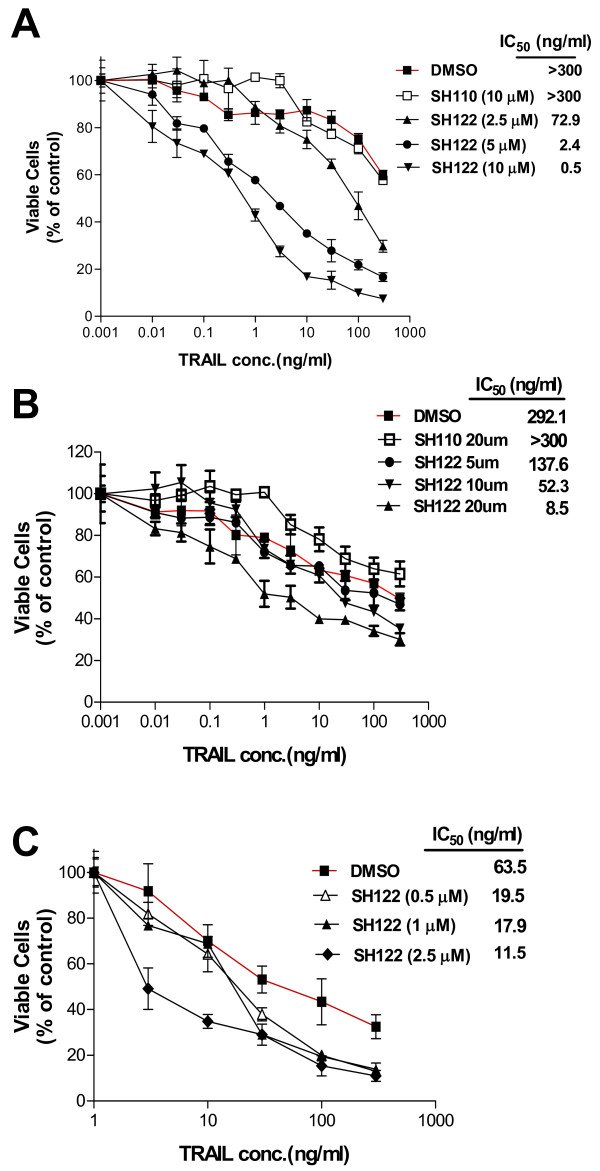
SH122 promoted TRAIL-induced cell death in prostate cancer cell line DU145 (A), LNCaP (B) and CL1 (C). Cells (5,000 cells/well in 96-well plates) were treated with different concentrations of TRAIL and SH122, alone or in combination, with SH110 as a negative control. After incubation for 96 h, cells were stained with Cell Counting kit-8 reagent. The optical density of each sample was measured. Data were normalized as described in Materials and Methods. Data were presented as mean ± SD (n = 3).